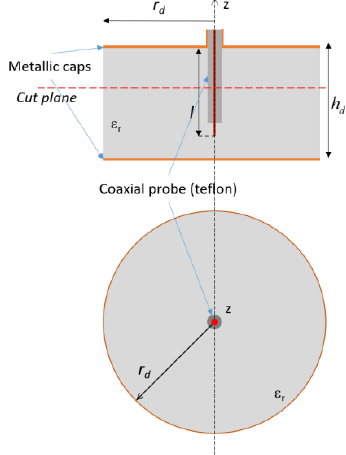
Figure 2. Lateral and top view of the first iteration for the tag design process.